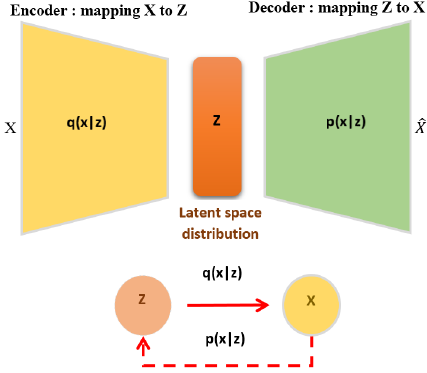
Figure 1. Basic schematic illustration of a variational autoencoder